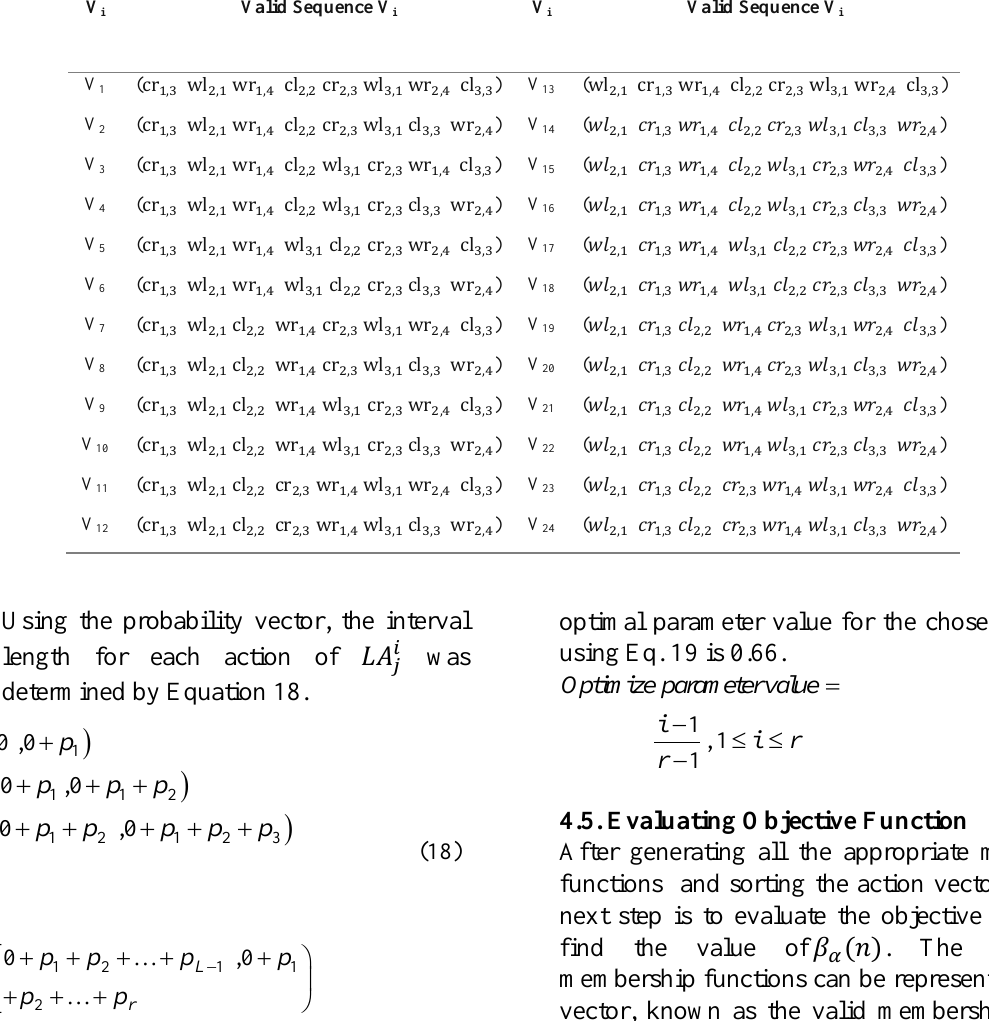
Table 2. Number of appropriate membership functions for the three trapezoidal membership functions. V i Valid Sequence V i V i Valid Sequence V